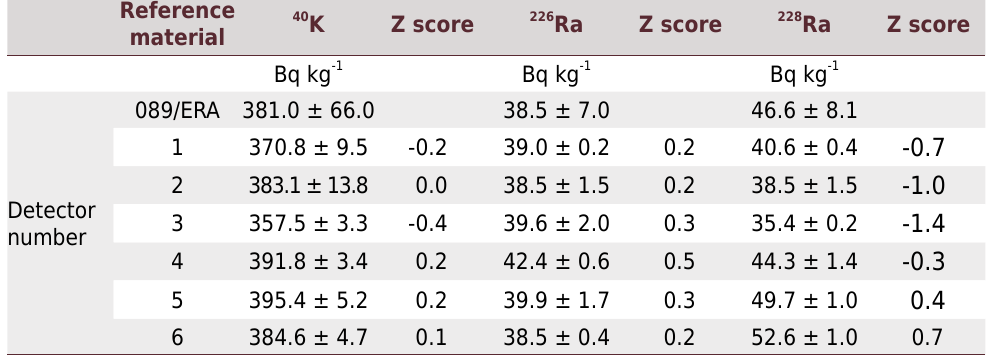
Table 1. Certified content and results of the analysis of the reference material of soil (089/ERA)